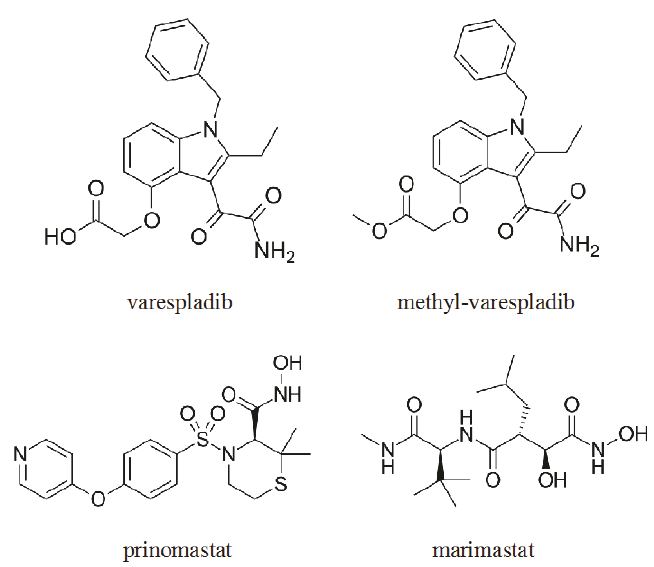
Figure 6: Structureof candidate SMTs for repurposing: varespladib (top left), its orally bioavailable pro-drug, methyl-varespladib (top right), prinomastat (bottom left), and marimatsat (bottom right). Marimastat and prinomastat are both orally bioavailable and could be combined (mixed or copackaged) for more extensive coverage as field antidotes [1,